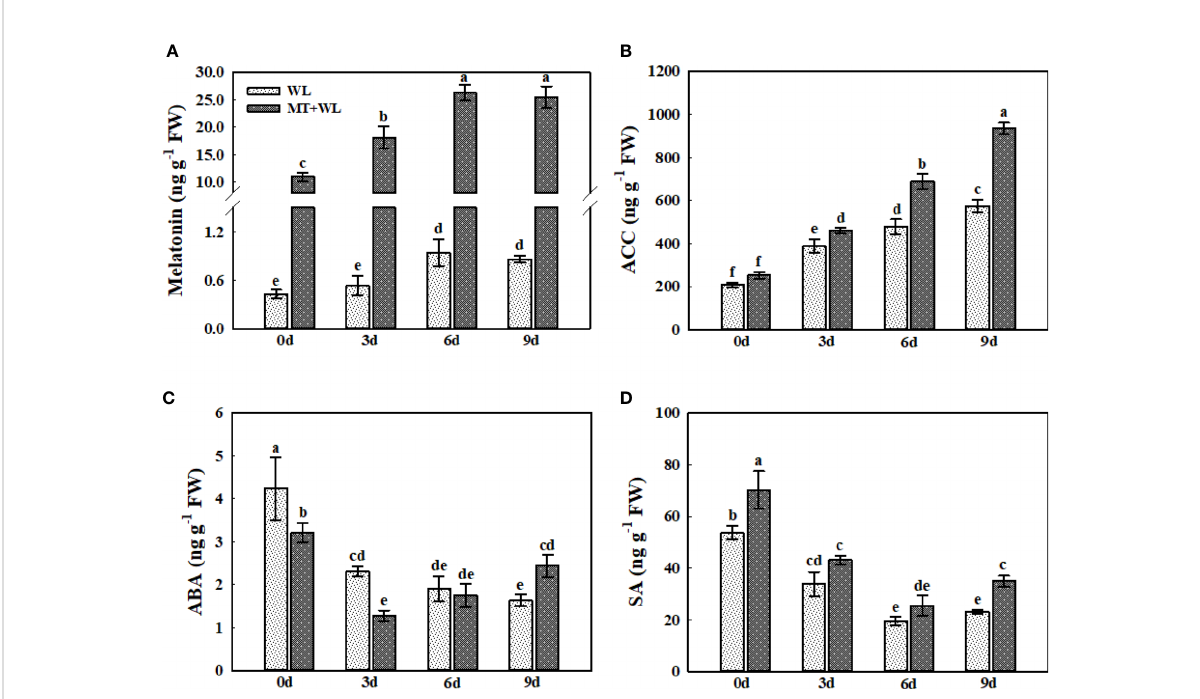
FIGURE 8 The concentrations of melatonin, ACC, ABA, and SA in the roots of kiwifruit plants under waterlogging stress, as measured by LC-MS. Data are shown as the means of three replicates with SEs. Different letters indicate signi fi cant differences between treatments, according to one-way ANOVA and Tukey ’ s multiple range test (P <